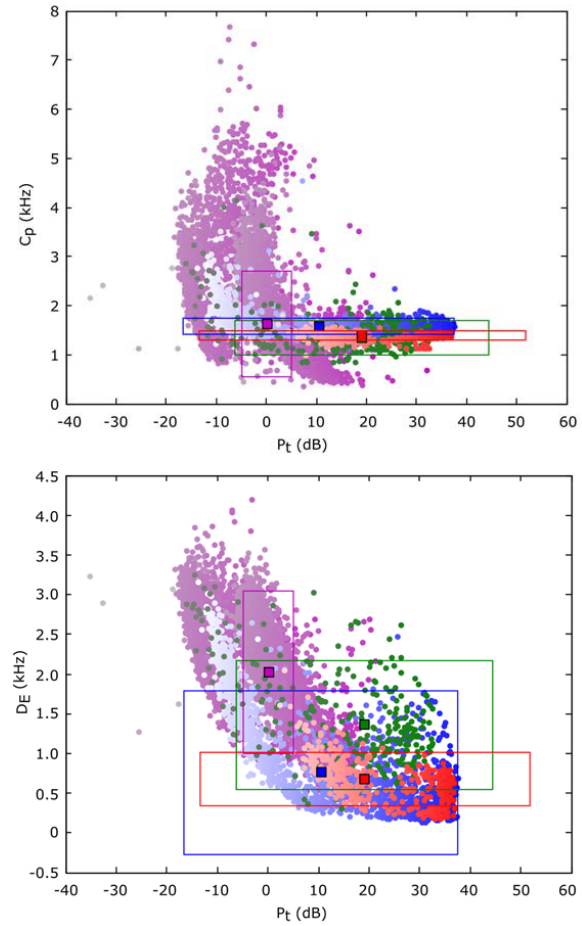
Figure 9. Point cloud of (cid:2159) (cid:2198) and (cid:2160) (cid:2161) descriptors versus its power in patterns.